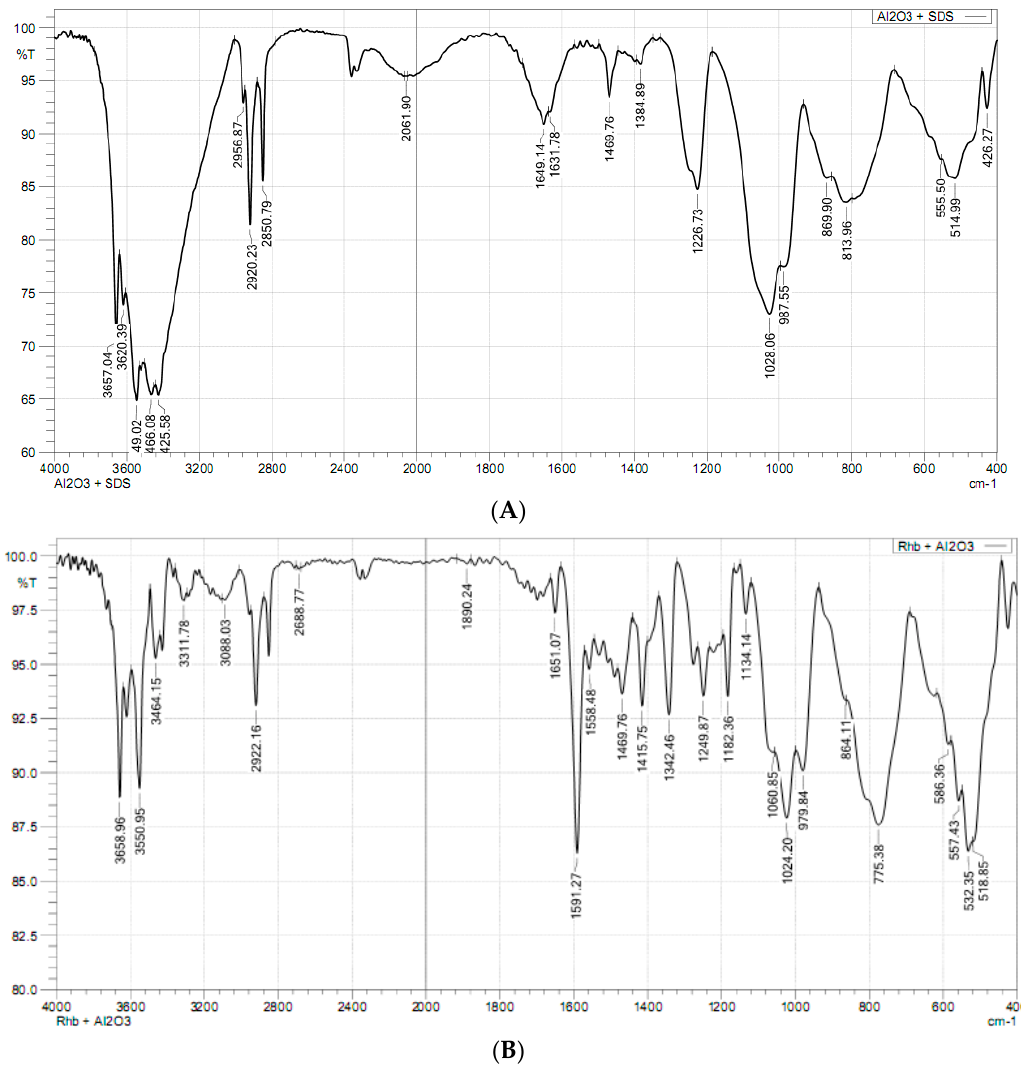
Figure 12. The FT-IR spectra of SDS modified nano γ -Al 2 O 3 ( A ) and SMNA after RhB adsorption ( B ).